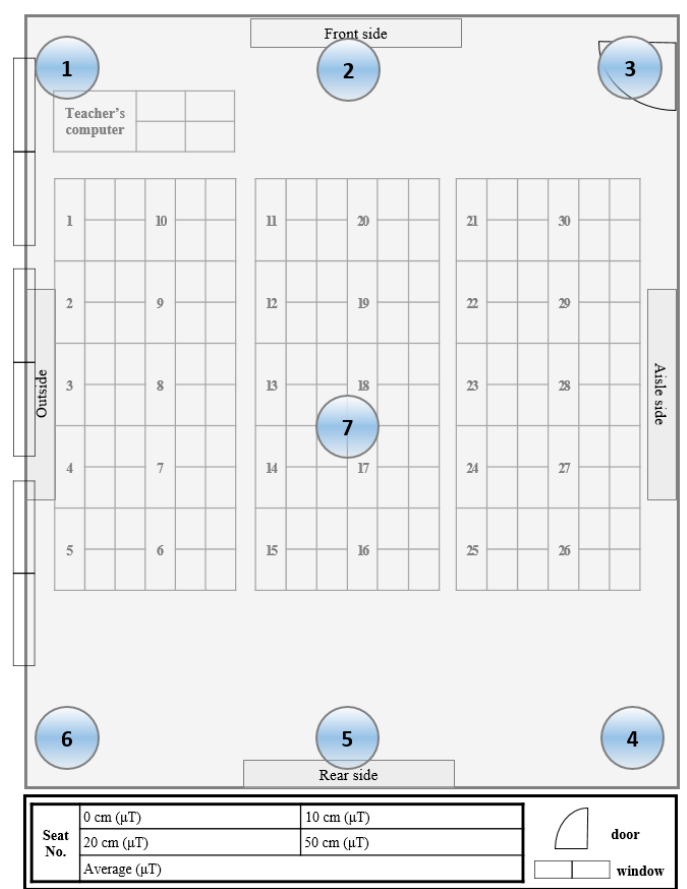
Figure 1. Measurement positions of extremely low-frequency magnetic fields in the classroom.